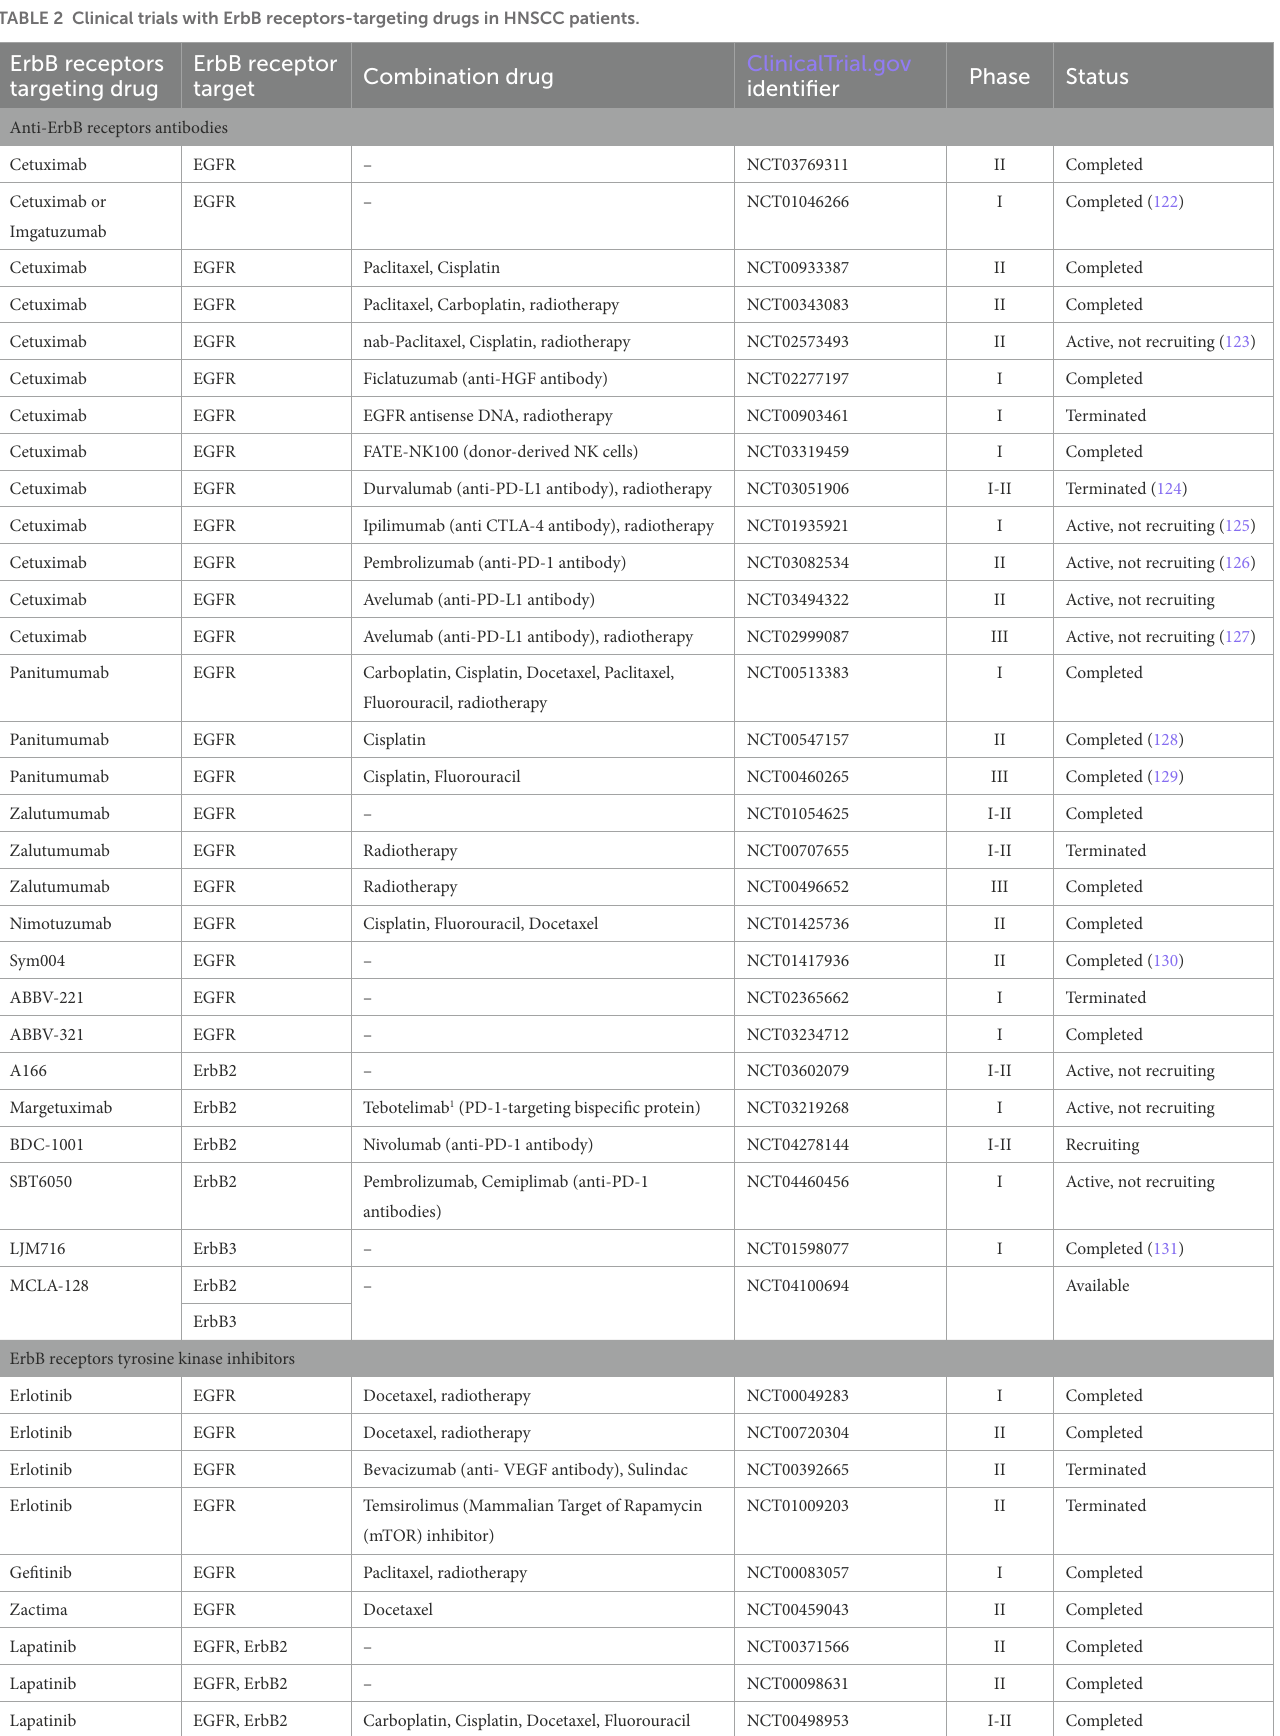
ClinicalTrial.gov identifier